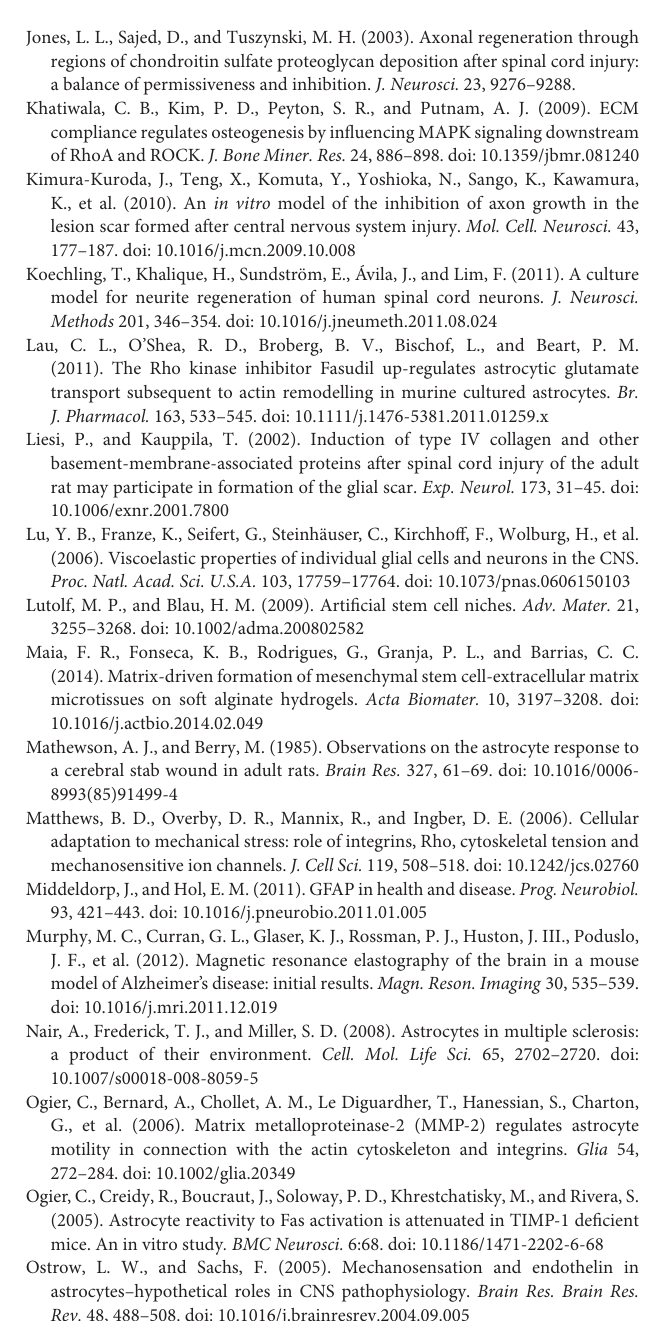
Image 1 | Evaluation of cell viability of 3D cultured control astrocytes. Representative photos of live-dead assay. Live cells are stained with Calcein-AM (green) and dead cells are stained with propidium iodide (red). Image 2 | Quantification of chondroitin 4 sulfate (CS4) of astrocyte cultures treated with fibroblast conditioned medium (CM) with the highest levels for each tested condition. For each time point 3 samples from independent experiments were loaded in the gel. Quantification graph refer to whole lane ( n = 3 ; mean ± standard deviation; no statistical differences were found).